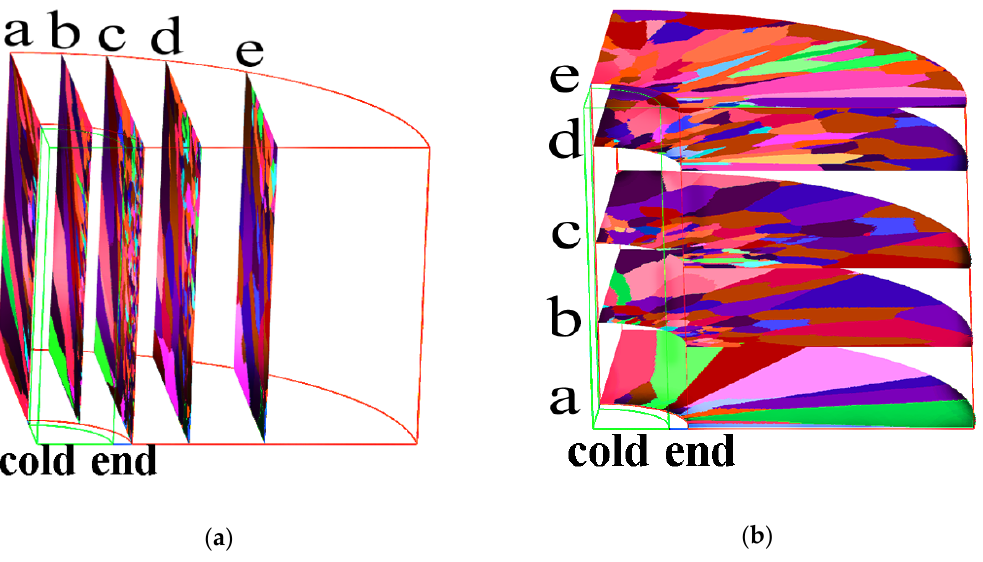
Figure 13. Microstructure predicted at the different sections: ( a ) axial sections, ( b ) radial sections.